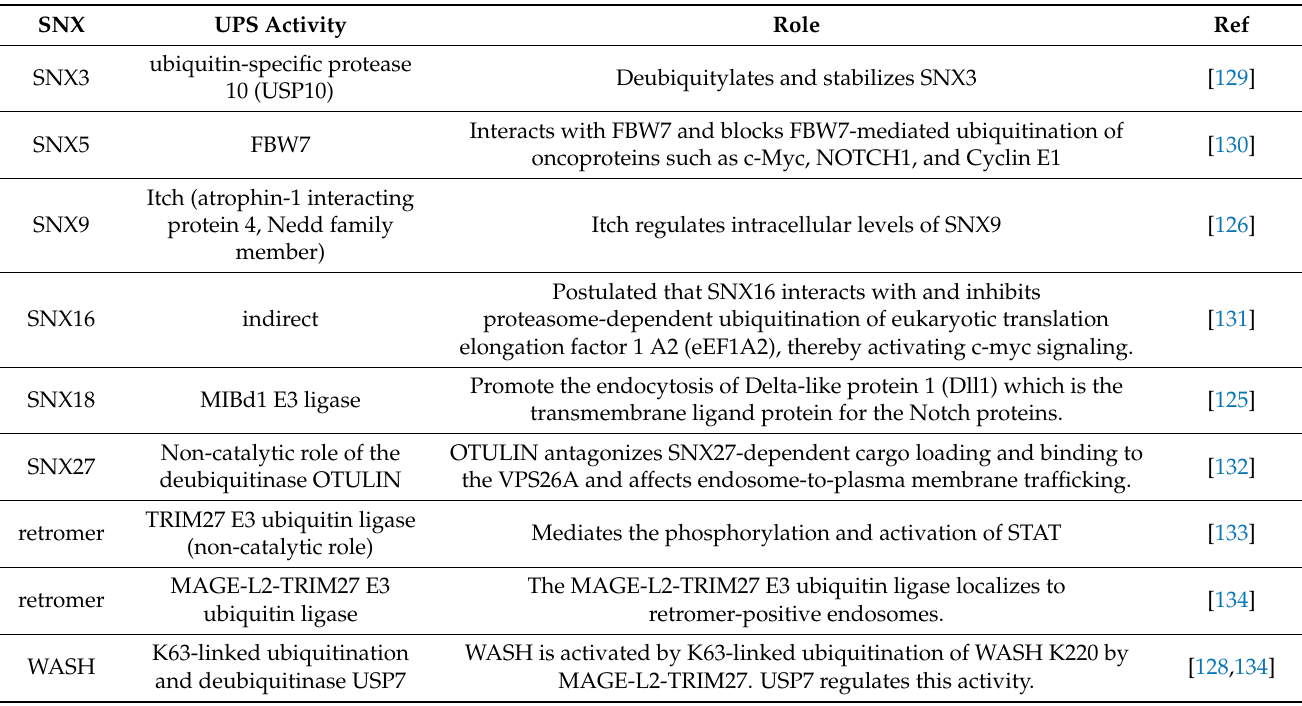
Table 1. List of mammalian sorting nexins and associated proteins (WASH) that play a role in the UPS.